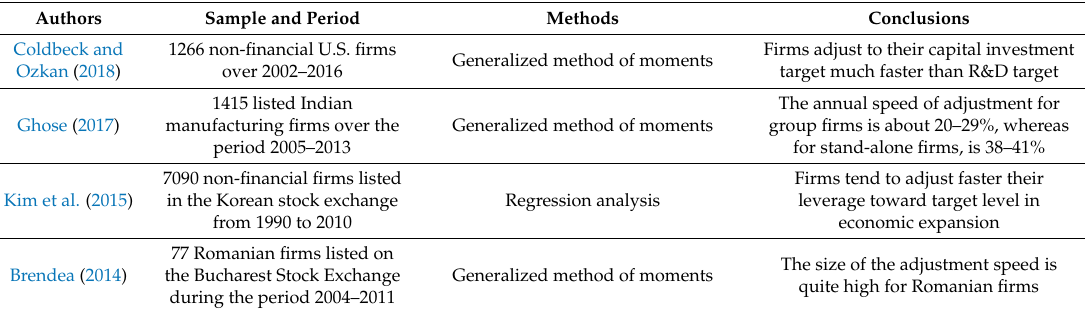
Table 3. Brief review of literature on capital structure adjustment